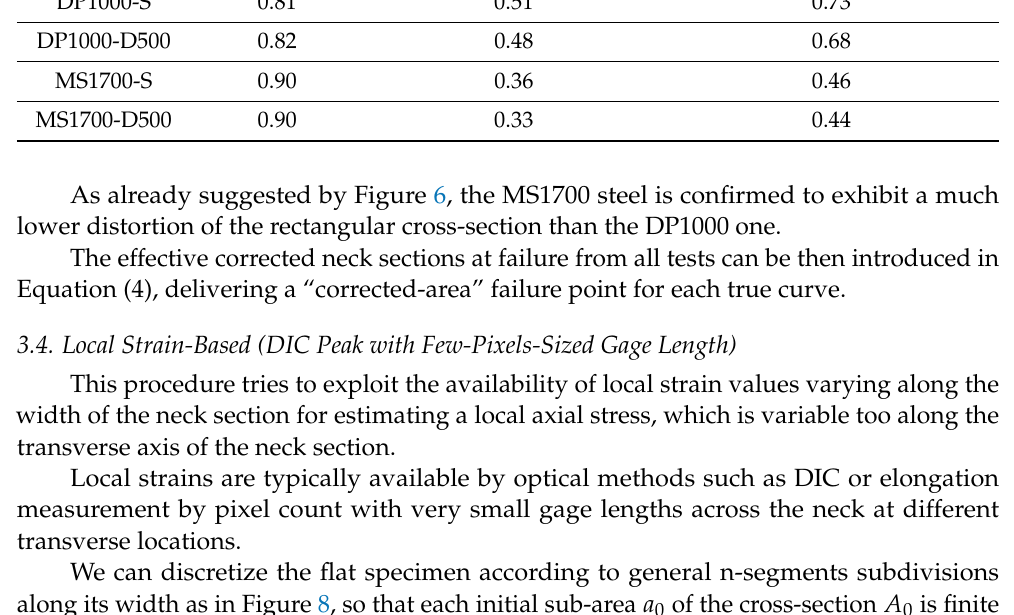
Table 3. Apparent and effective cross-sections at failure for DP1000 and MS1700 steels (series- averaged data). Ratio A eff. /A